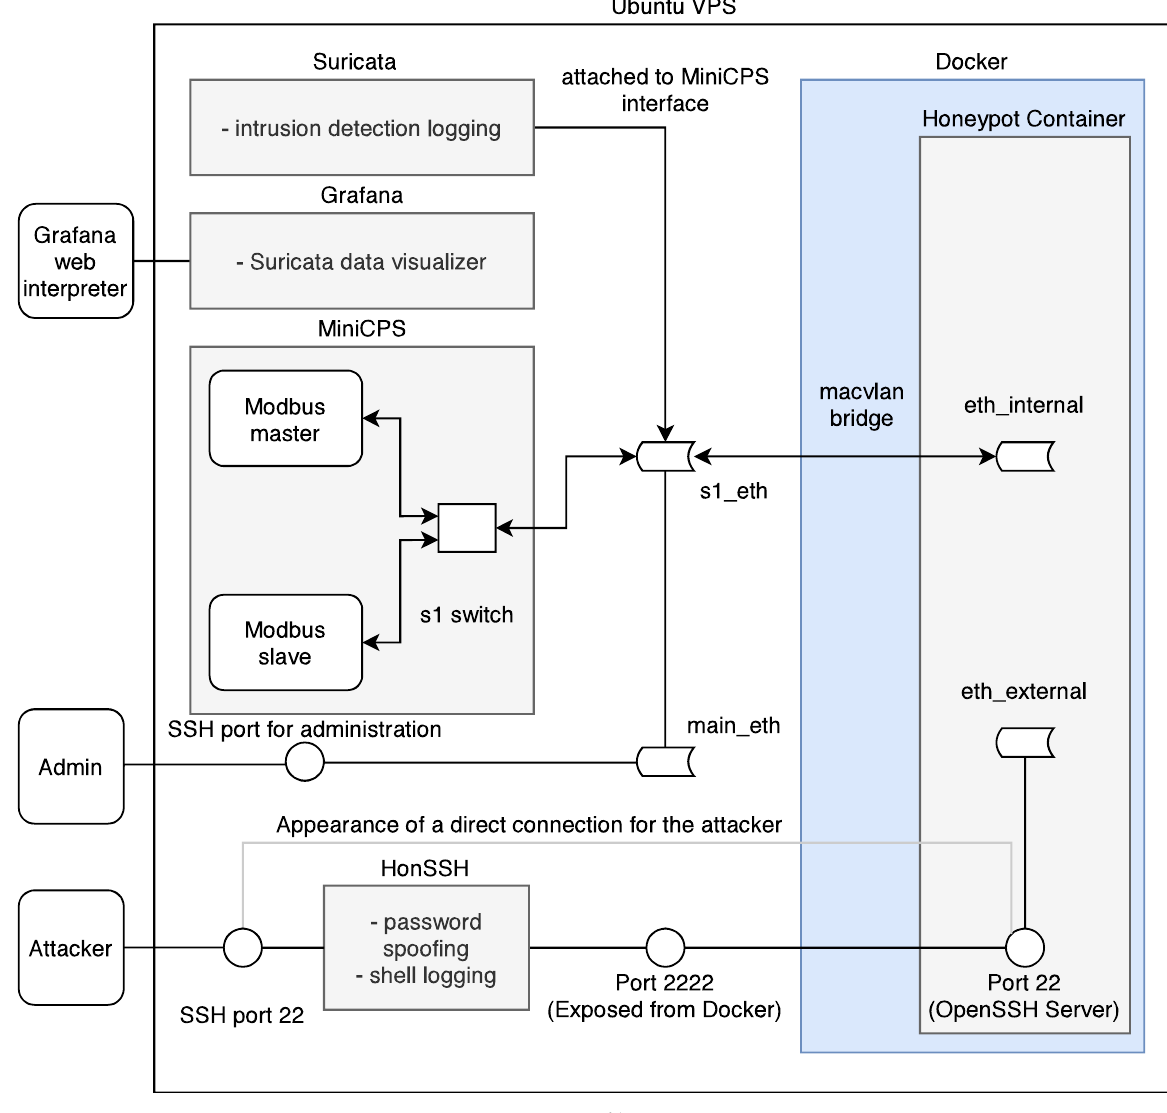
Figure 9. Diagram of honeypot